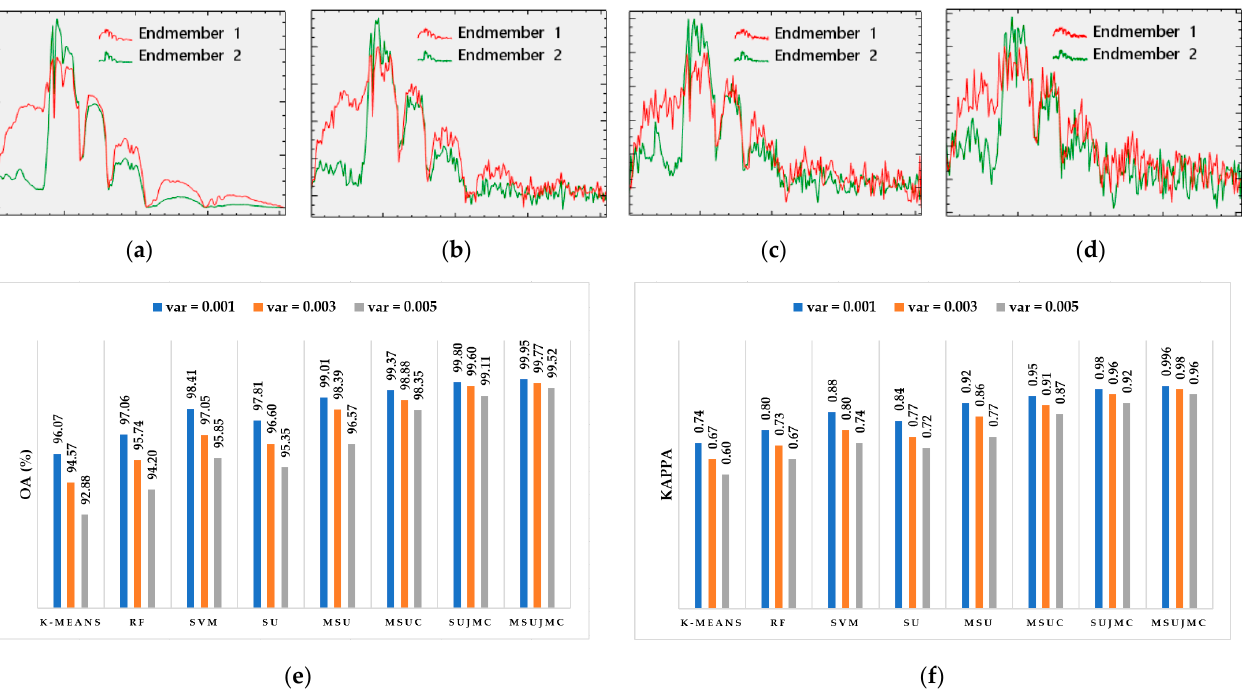
Figure 8. Spectral curves at different noise levels: ( a ) without noise; ( b ) with Gaussian white noise (variance = 0.001); ( c ) with Gaussian white noise (variance = 0.003); ( d ) with Gaussian white noise (variance = 0.005). Experimental results of the simulated dataset under different levels of noise: ( e ) the OA of each method for the simulation dataset under different levels of noise; ( f ) the KAPPA of each method for the simulation dataset under different levels of noise.